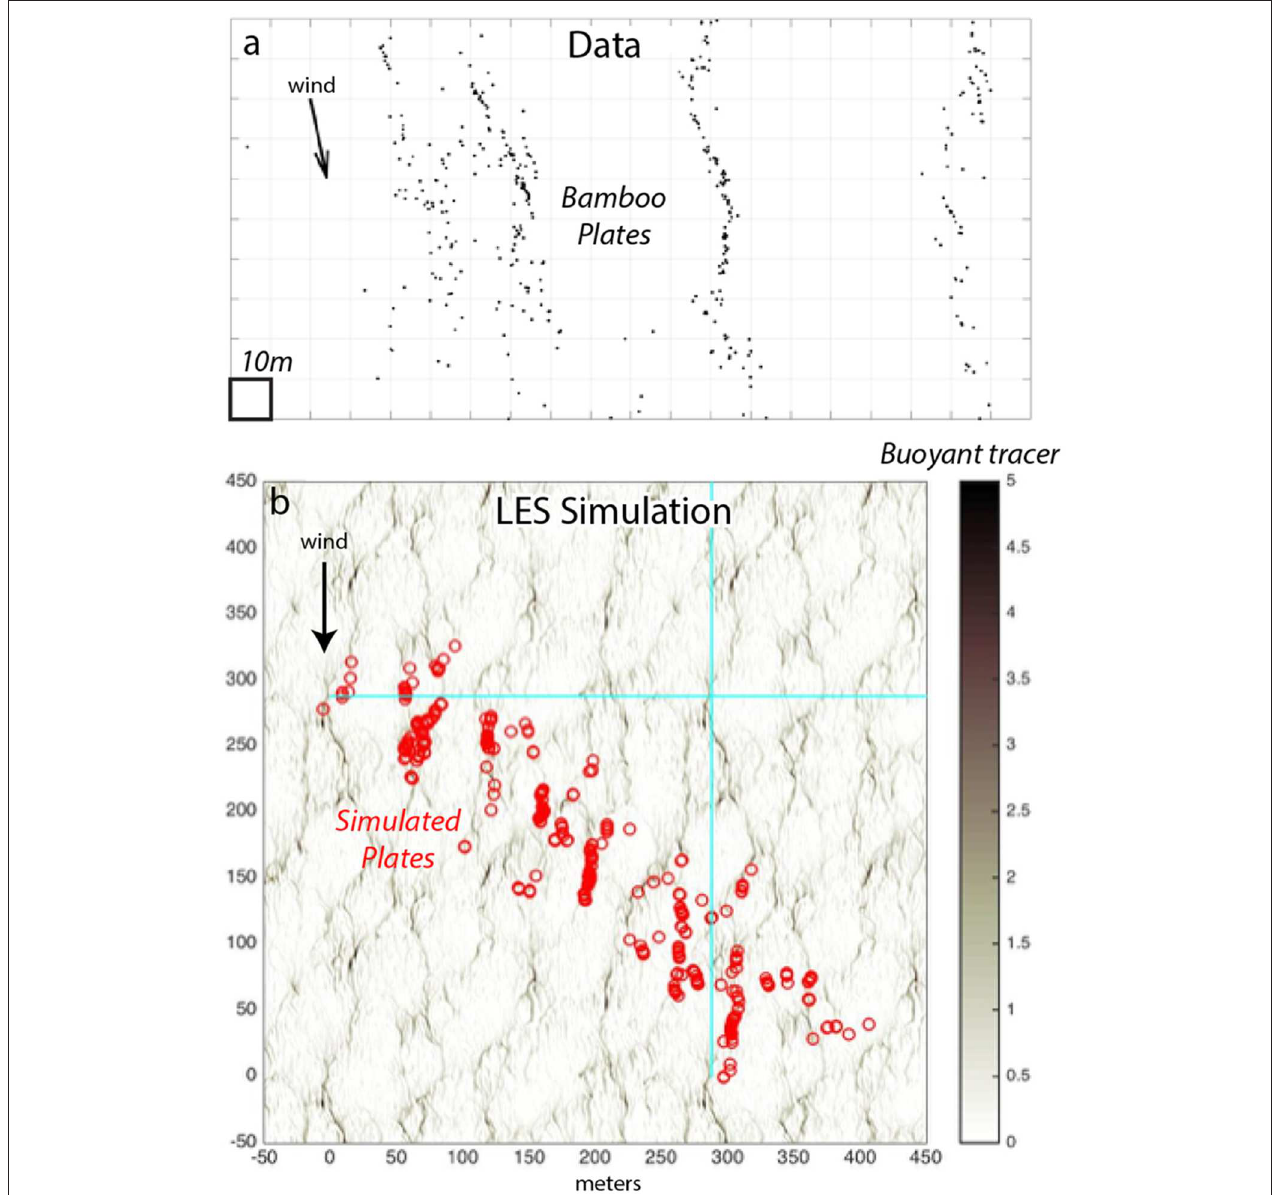
FIGURE 11 | Clustering of surface particles in (a) Aerostat tracked bamboo plates during CARTHE LASER 125 min after deployment (from Chang et al., 2019). (b) LES simulation of these observations using observed stratification, forcing, and surface waves. Plates are shown in red; the concentration of a continuous buoyant tracer is shown in gray. Blue lines show boundaries of the spatially periodic simulation domain. Aerostat bamboo plate data are available at Carlson et al.